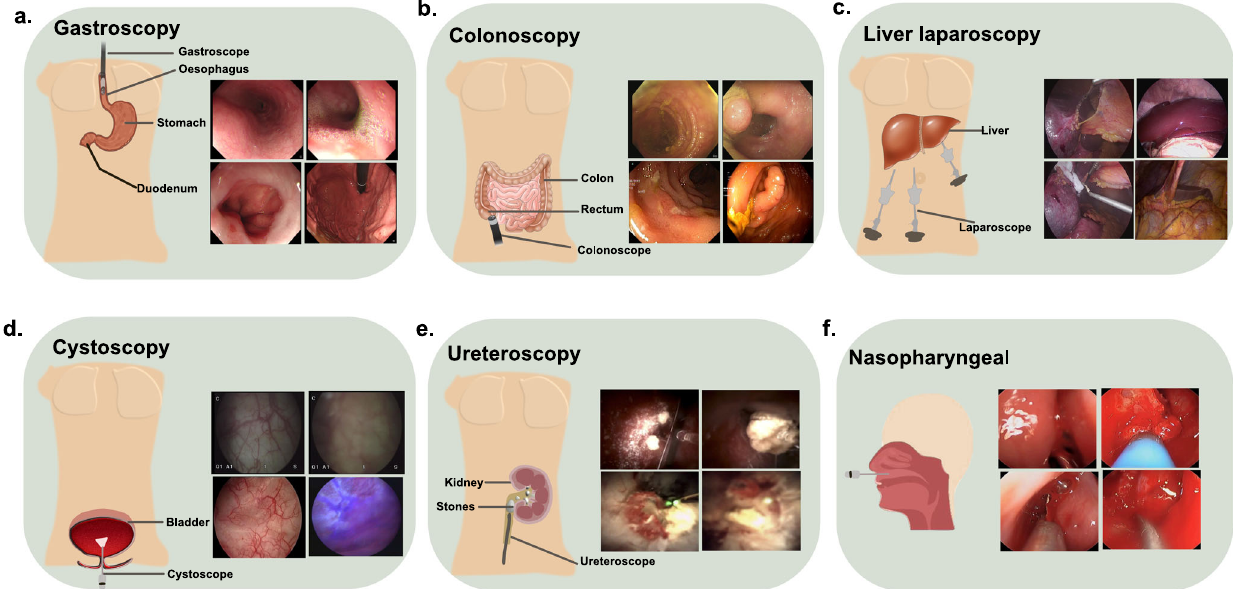
Fig. 2 Different endoscopic acquisition systems for various hollow organs. a Gastroscopy procedure during which a fl exible endoscope is inserted to visualise mucosa in the oesophagus and stomach parts of the duodenum. It can be observed that the scene varies quite a lot depending on the scope location. Similarly, in the top left image, one can observe bubbles surrounding the mucosa. b Colonoscopy procedures cover the colon and rectum, during which fl exible endoscopes are used to navigate this complex twisted organ. Bowel cleansing is an essential preparation as it can occlude lesions. In most images, the presence of stool is a clear mark of occluded anomaly. c During laparoscopy, usually rigid endoscopes are inserted through small incision holes. Images depicting fat surrounding the liver, a clear view of the liver, the presence of tools during surgery and complete occlusion of the liver due to fat are shown. d Widely used rigid endoscopes are used for investigating bladder walls that are inserted through the urethra. Conventional white light image modality ( fi rst three) and fl uorescence image (blue) modality are shown 125 . It can be observed that the top two images are blurry showing little or no vessel structures. e Kidney stone removal using ureteroscopy and laser lithotripsy. The difference in texture and surrounding debris (in top) and blood (bottom) for in vivo images 71 . f A fl exible endoscope enters through the nostrils and can go from the nose up to the throat area and is hence collectively called nasopharyngeal endoscopy. Images (on the left) show a small opening and fi eld of view, along with surgical tools for some cases 126 . The sources of relevant endoscopy images: gastroscopy and colonoscopy images in ( a and b are acquired from Oxford University Hospitals under Ref. 16/YH/0247 and forms part of publicly released endoscopy challenge datasets (EDD2020 127 under CC-by-NC 4.0 and PolypGen 128 under CC-by, Dr S. Ali is the creator of both datasets). Liver laparoscopy data are taken from the recently conducted P2ILF challenge 129 (Dr S. Ali is the creator of this dataset), while cystoscopy and ureteroscopy data are respectively taken from PhD thesis of Dr S. Ali 130 and a recently